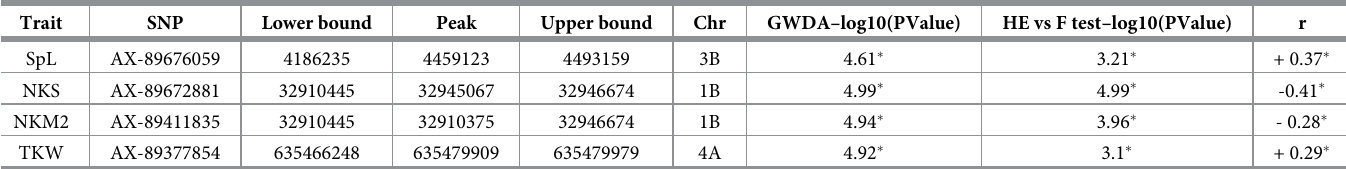
Table 2. HE-QTLS Significant associations between genetic diversity and traits. Trait SNP Lower bound Peak Upper bound Chr